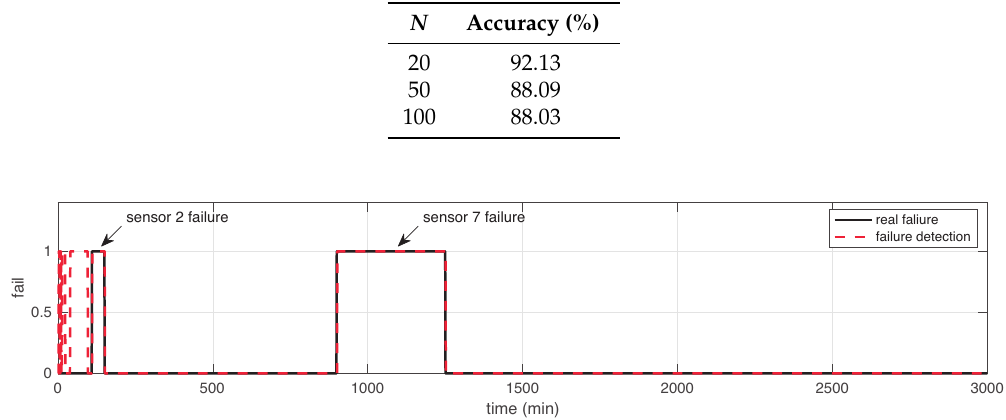
Figure 9. Failure detection response in the system, for N =